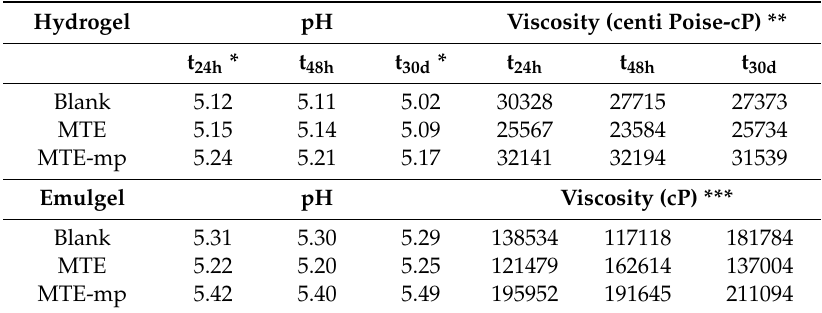
Table 1. pH and viscosity values of produced hydrogels and